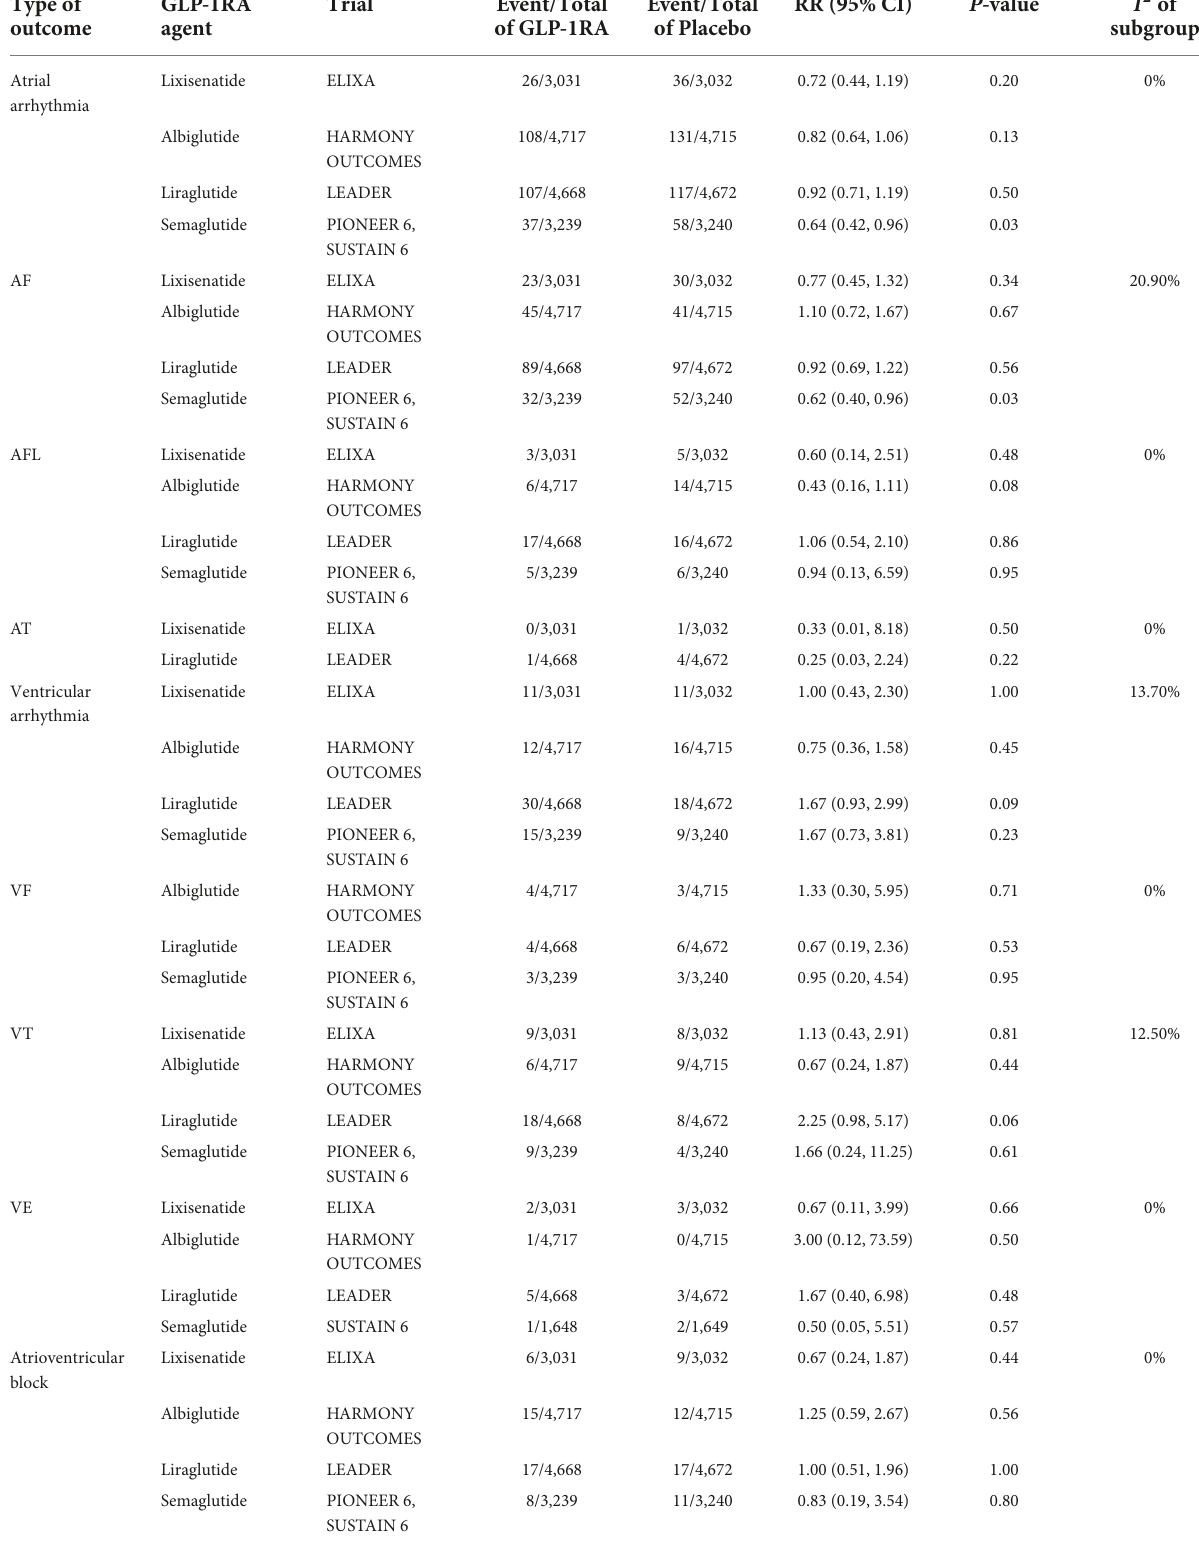
TABLE 2 Result of subgroup